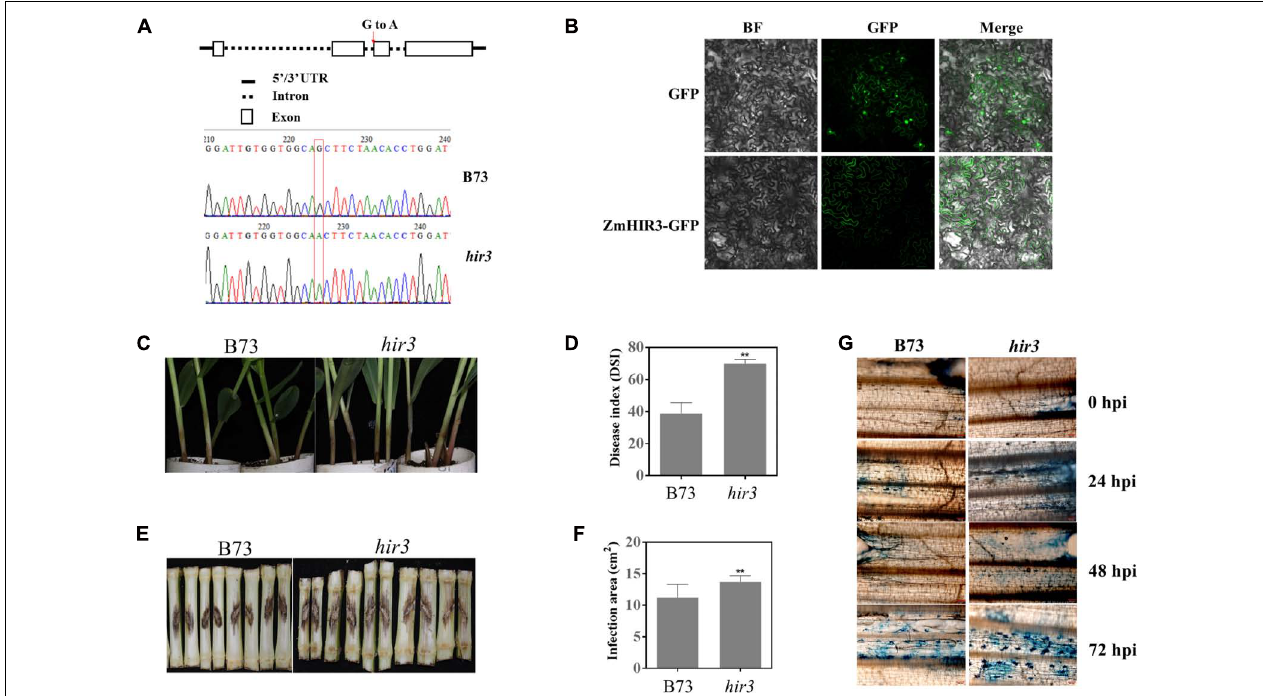
FIGURE 11 | Identification and GSR phenotypic analysis of zmhir3 mutant in response to F. graminearum infection. (A) Identification of zmhir3 EMS mutant by resequencing. The top schematic diagram represents the SNP mutation in ZmHIR3 gene. The red arrow shows the mutation of G to A in the end of second intron of gene. The bottom indicates the mutation of SNP G to A by resequencing. (B) Subcellular localization of ZmHIR3 on the plasma membrane. BF, bright field. (C) Seedling GSR phenotypes of zmhir3 mutant versus wild-type B73. The phenotype was recorded at 3 dpi. (D) Quantification of seedling GSR disease index (DSI) of zmhir3 mutant vs. wild-type B73. (E) Field GSR phenotypes of zmhir3 mutant vs. wild-type B73 recorded at 15 dpi. (F) GSR disease areas on the stems of zmhir3 mutant vs. wild-type B73 adult plants in the field condition. ∗∗ Statistically significant ( p < 0.01) between mock and inoculation treatments analyzed by t -test. (G) Trypan blue staining of cell death on the stems of zmhir3 mutant vs. B73 seedlings at different time points upon infection with F. graminearum . The scale on the picture is 50 µ m. hpi, hours